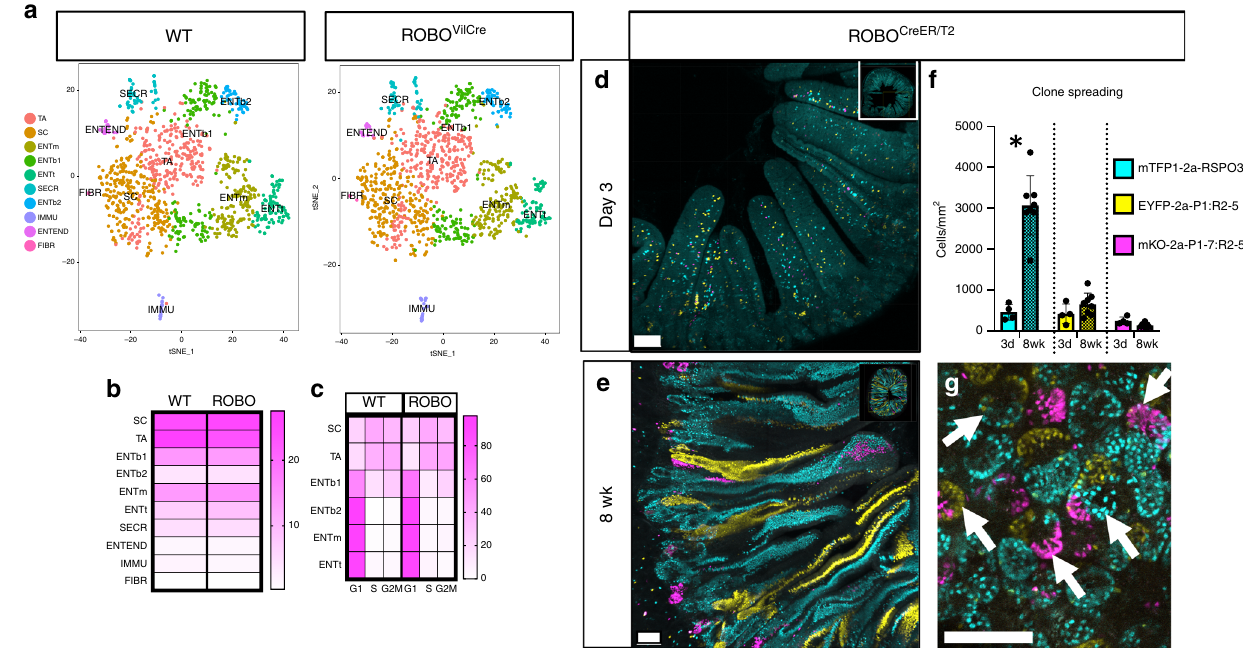
Fig. 7 Microenvironmental oncogenesis drives heterogenous premalignant clones in adults. a Single cells were isolated from PND16 WT and ROBO VilCre by fractionation to enrich for crypt epithelium. scRNAseq and t SNE visualization was performed for WT and ROBO VilCre cells. (SC: stem cell, TA: transiently amplifying cell, ENT: enterocytes that included bottom (b1: S/G2M phase and b2: G1), middle (m), and top (t), and were recently described 45 , SECR: secretory Paneth and Goblet cells, IMMU: immune, ENTEND: enteroendocrine, FIBR: fi broblast). For cell type markers, see also Supplementary Fig. 14. b Heatmap visualization of cell types present in WT and ROBO VilCre isolates as a percentage of total cells. c Heat map visualization of cell cycle phase as a percentage of each cell type. d – g ROBO CreER/T2 ( N = 9 mice, 6 – 15 weeks of age) were I.P. injected with 200 mg/kg of tamoxifen and sacri fi ced 3 days ( N = 4) or 8 weeks later ( N = 5), and the small intestine was vibratome sectioned and imaged by tiling confocal microscopy. Confocal imaged vibratome sections of ROBO CreER/T2 small intestines at d 3 days or e 8 weeks post tamoxifen injection. f Nuclei were segmented and counted and normalized to the total volume imaged. Clone spread was determined by comparing the total recombined nuclei for each fate at 8 weeks relative to day 3. The asterisk denotes statistical signi fi cance by mixed effects modelling and Sidak multicomparison correction ( RSPO3 : <0.000001, PTPRK e1 :RSPO3 e2 – 5 (P1:R2-5): p = 0.31 and PTPRK e1 – 7 :RSPO3 e2 – 5 (P1-7:R2-5): p = 0.94). g Evidence for attenuated crypt fi xation 8 weeks post tamoxifen injection as revealed by chimeric crypts in whole-mount confocal imaging. (SEM included for each graph). Scale bars = 100 µ m in d , e , g . Source data are provided as a “ Source Data fi le ”